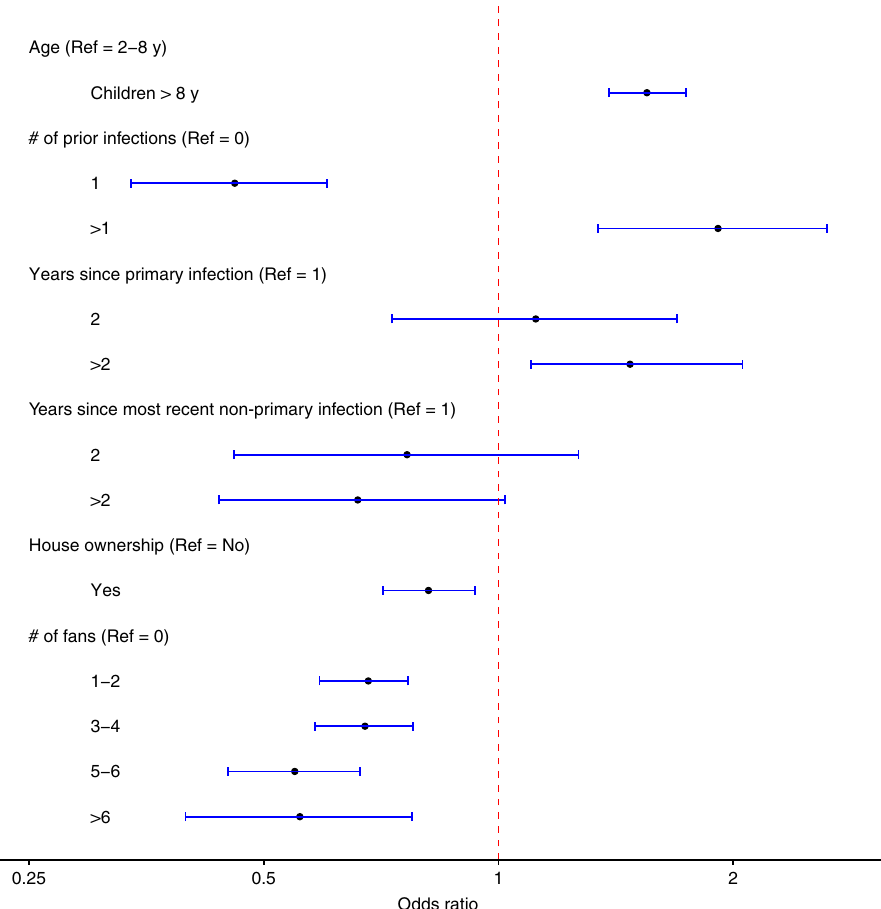
Fig. 2 Estimated effects of risk factors for DENV infection. Associations with the risk of DENV infection are shown as posterior medians (points) and 95% credible intervals (horizontal bars) of odds ratios for age group, number (#) of prior infections, years since most recent infection, home ownership and number of electric fans. The reference (Ref) group is children aged 2 – 8 years, without any prior infection, with no household ownership and no fan in their household. Source data are provided as a Source Data fi